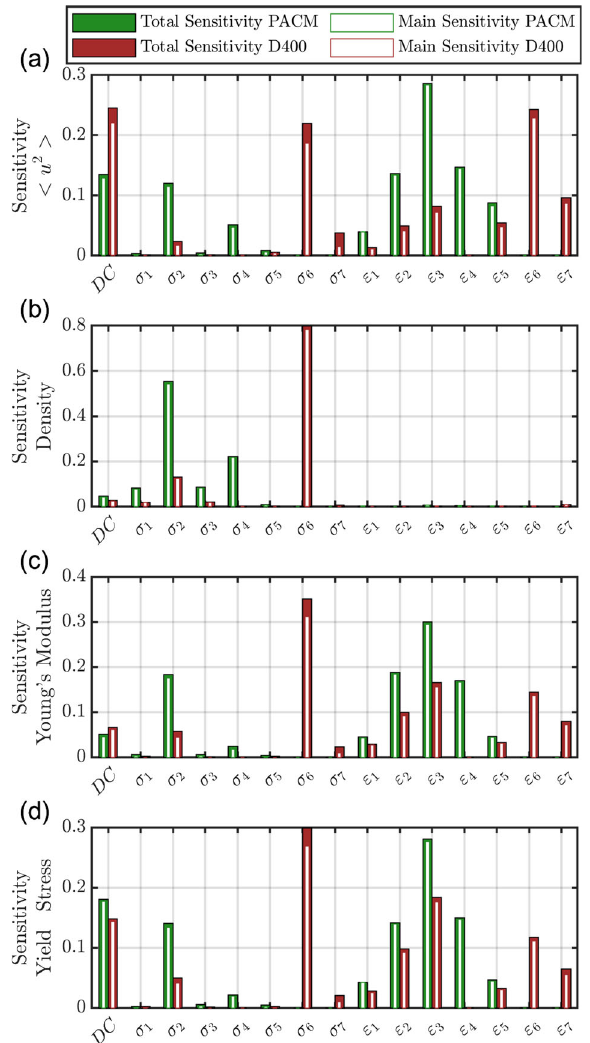
Fig. 3 Sensitivity analysis of the target properties varying ε i ; σ i ½ (cid:2) and DC across 1200 CG simulations. The main sensitivity index measures the effect of varying a single input variable on the output. The total sensitivity analysis measures how changing a single input variable affects its contribution to the variance of an output measure while accounting for its interaction with the rest of the input parameters. The density of the systems ( b ) is dominated by the σ i variables, as one would expect. Interestingly, DC has a stronger effect on 〈 u 2 〉 ( a ) and the yield stress ( d ) than on the density and the Young ’ s modulus ( c ). The analysis sheds light on the role of different cohesive energies on the dynamics and